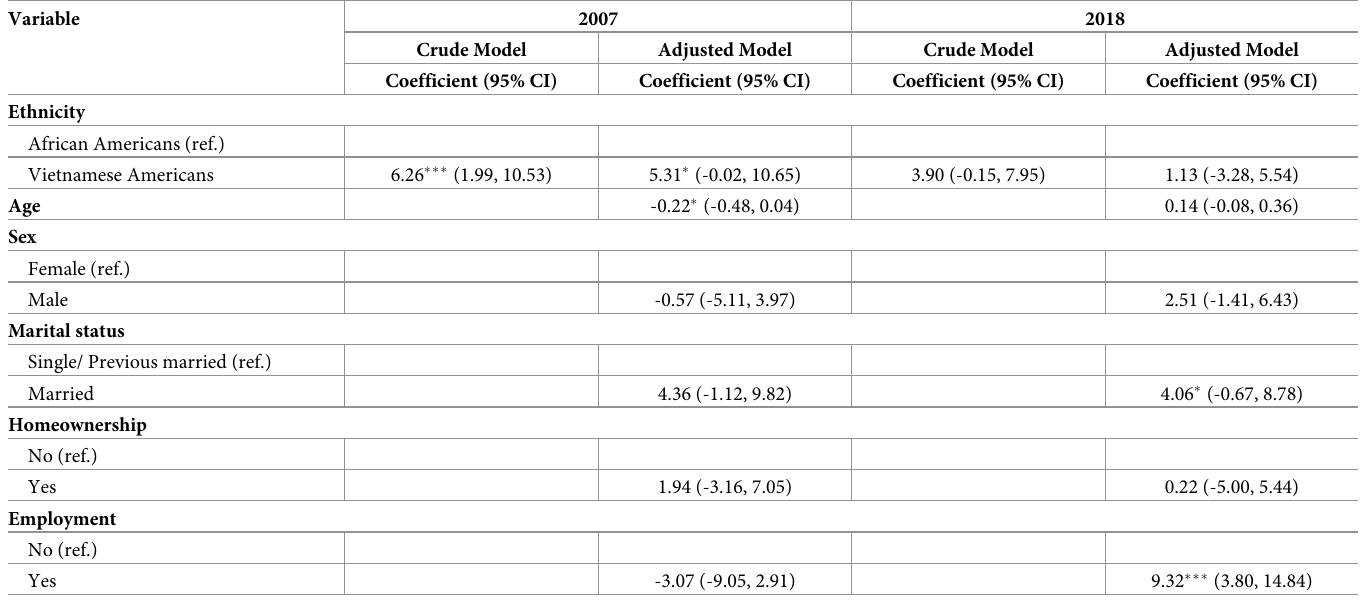
Table 2. Differences of post-disaster mental health between African American and Vietnamese American participants in 2007 (N = 144) and 2018 (N = 109), apply- ing linear regression